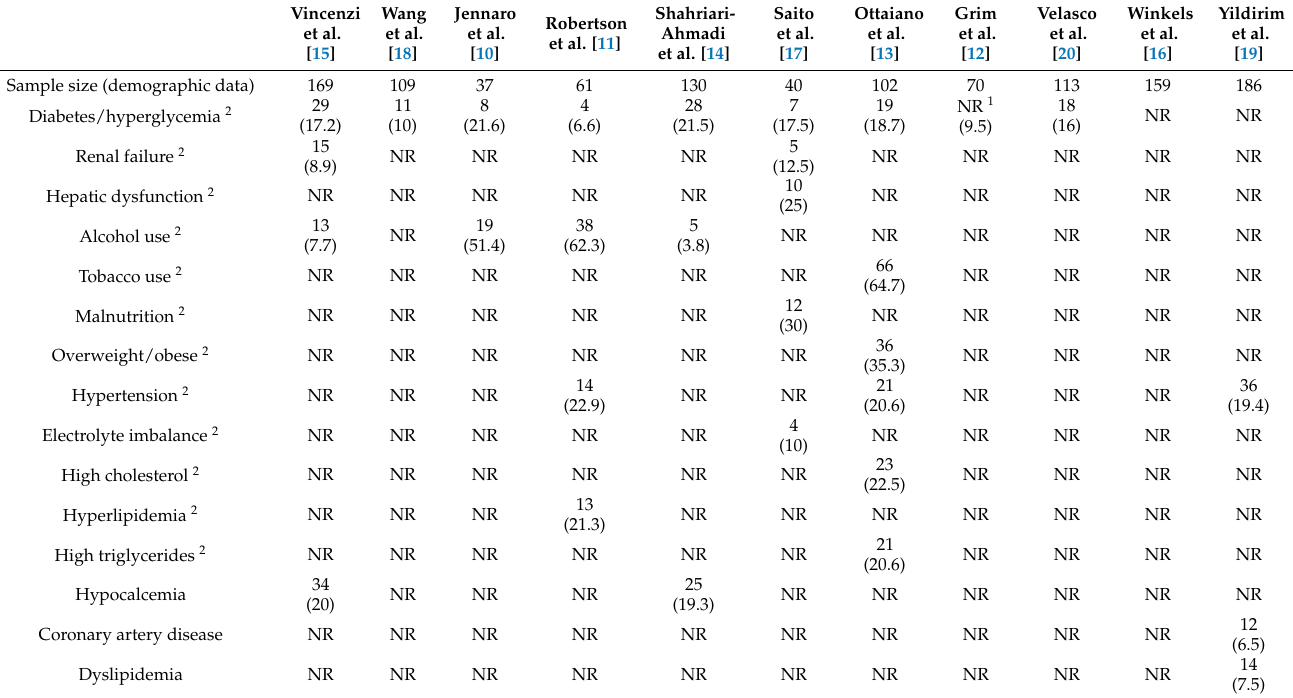
Table 3. Comorbid conditions reported in each